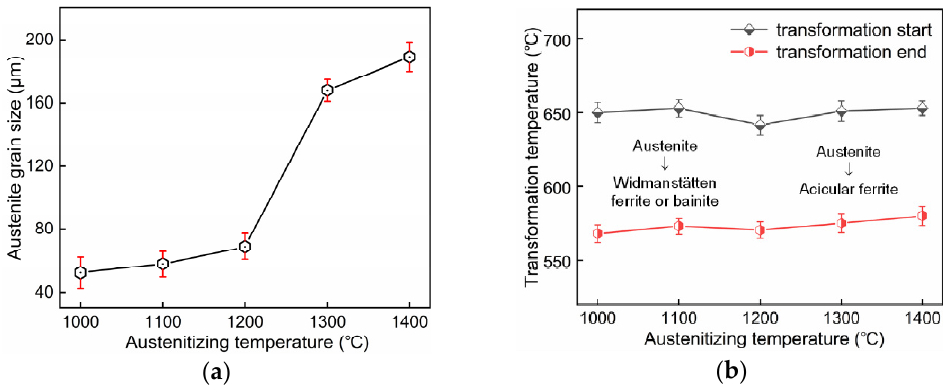
Figure 6. Effects of austenitizing temperature on ( a ) austenite grain size and ( b ) transformation temperature.